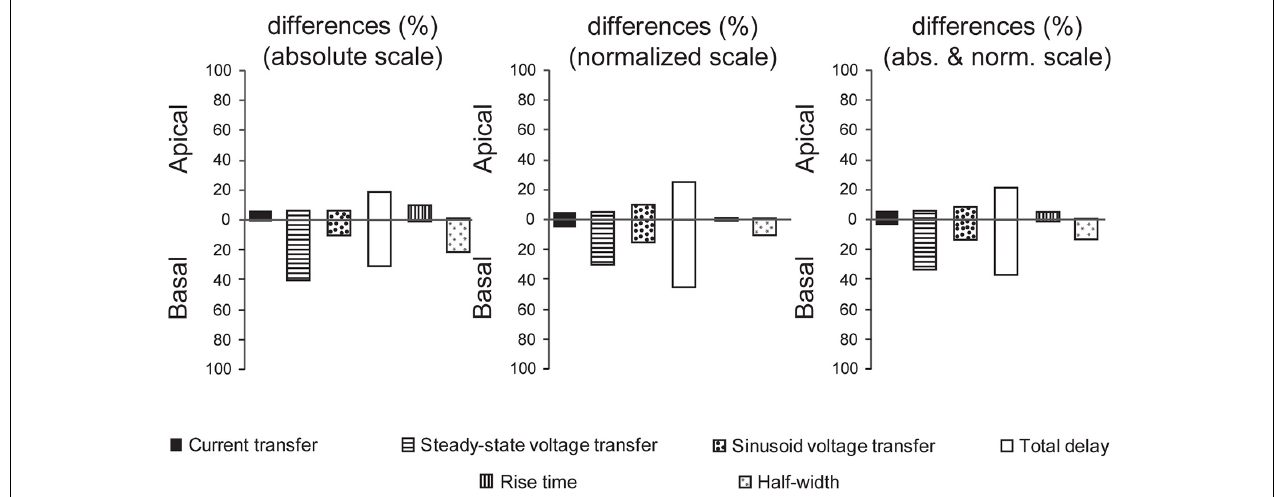
FIGURE 11 | Comparisons of mutant human tau-induced alterations in dendritic signaling. Percentage of intervals where significant alterations in dendritic signaling were detected in TG neurons along absolute and normalized scales of comparison graphs as well as grand summary combining alterations detected along both scales. Upper and lower extensions of bars show alterations in apical and basal dendritic arbors, respectively. Data shown here are based on comparison graphs presented in Figures 5–10 . The total number of intervals with at least 3–3 data points for WT and TG neurons was taken as